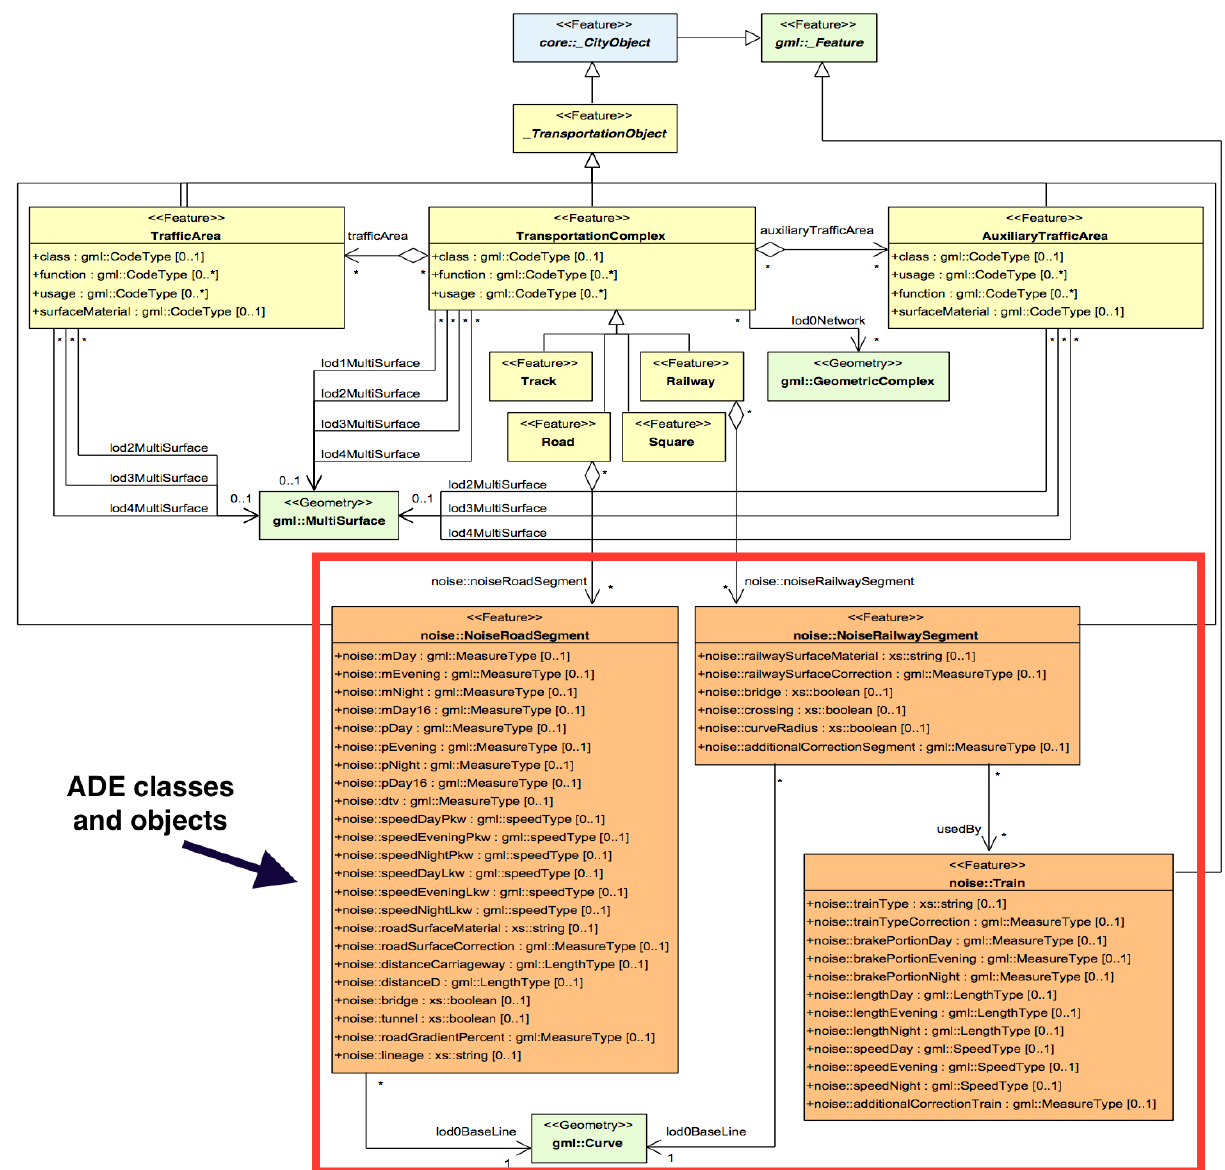
Figure 8: CityGML Noise ADE UML for roads and railways(light yellow=CityGML Transportation module, light orange=CityGML Noise ADE) (Groger et al.,